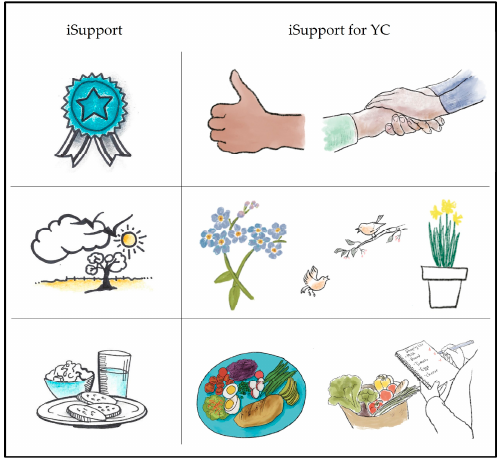
Figure 5. Examples of adaptations to illustrations.